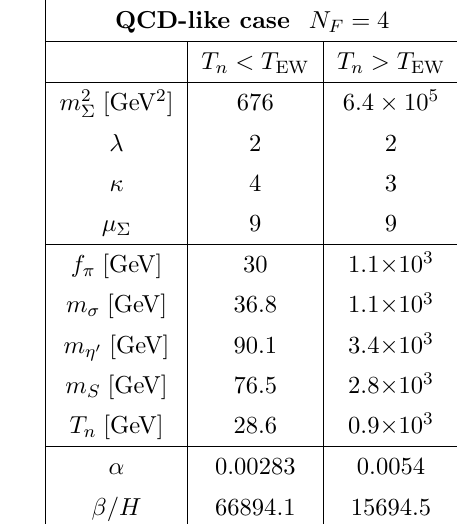
Table 1. Values of the linear sigma model parameters, physical meson masses and relevant quan- tities entering the GW spectrum calculation of the N